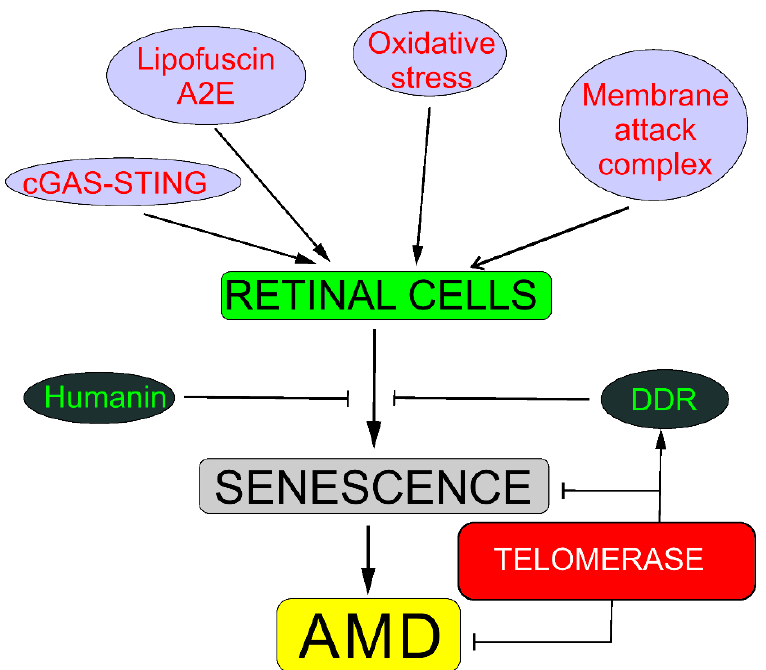
Figure 2. Telomerase may protect against senescence that may be causal in age-related macular degeneration (AMD). Oxidative stress evokes stress-induced premature senescence in all kinds of retinal cells, whereas membrane attack complex evokes degeneration of choriocapillaris through senescence in chorioretinal endothelial cells. Lipofuscin and its fluororophore A2E (N-retinylidene-N-retinyl-ethanolamine) show cytotoxic action against retinal cells through mechanisms with the involvement of redox reactions supported by the presence of iron in lipofuscin. Cyclic GMP–AMP synthase (cGAS) detects DNA in the cytosol, leading to the promotion of stimulator of interferon genes (STING), and induces senescence in the response to DNA damage. DNA damage response (DDR) may recover DNA damage, preventing oxidative shortening of telomeres or the activation of the cGAS-STING pathway. Humanin, a mitochondria-encoded peptide, exerts a protective effect against oxidative stress and endoplasmic reticulum stress in human retinal pigment epithelium cells and direct protection against senescence. Different background colors are for better distinguishing different elements.